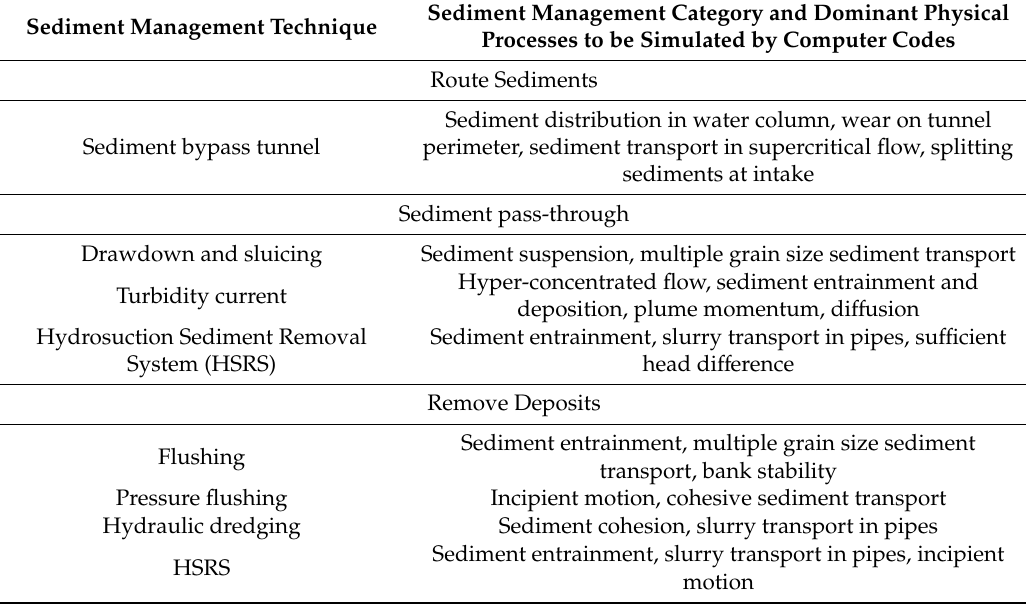
Table 1. Dominant physical processes associated with sediment management